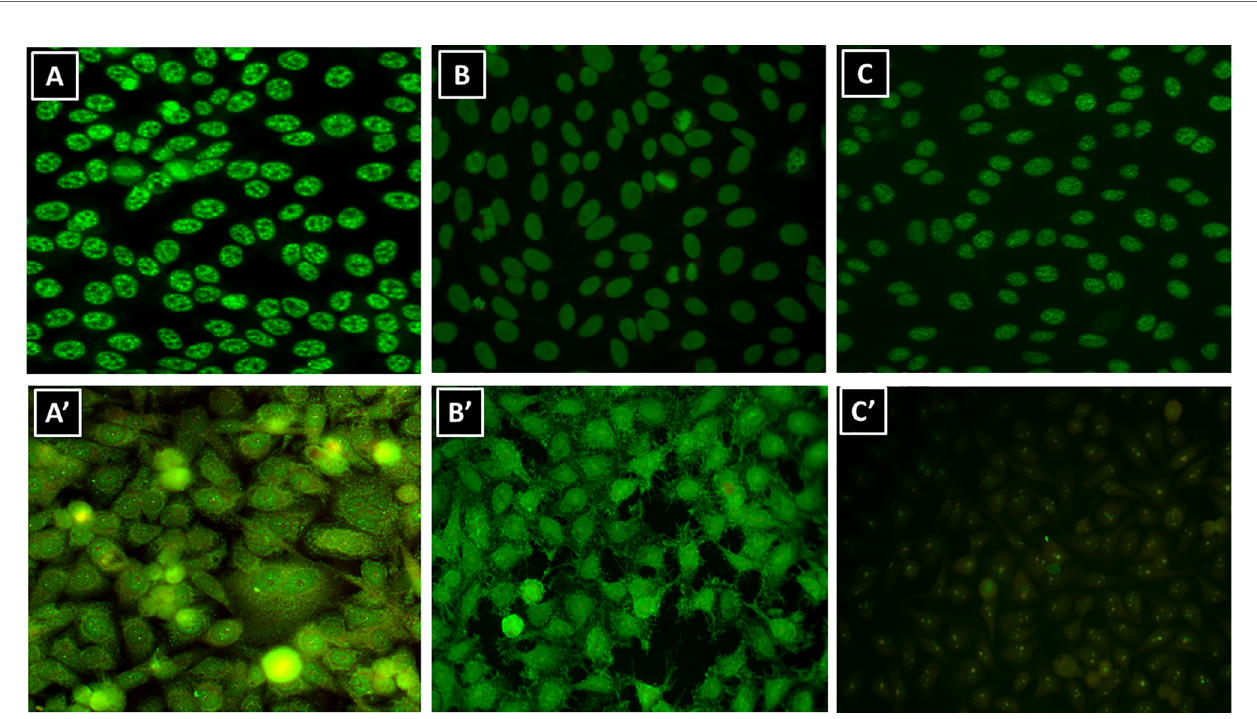
FIGURE 1 | Interkit nonreproducibility of the HEp-2-IFA test. Representative serum samples from the laboratory routine operation diluted 1/160 and processed in different HEp-2-IFA kits according to the manufacturer ’ s instructions. (A , A ’ ) Serum #1; (B , B ’ ) serum #2; (C , C ’ ) serum